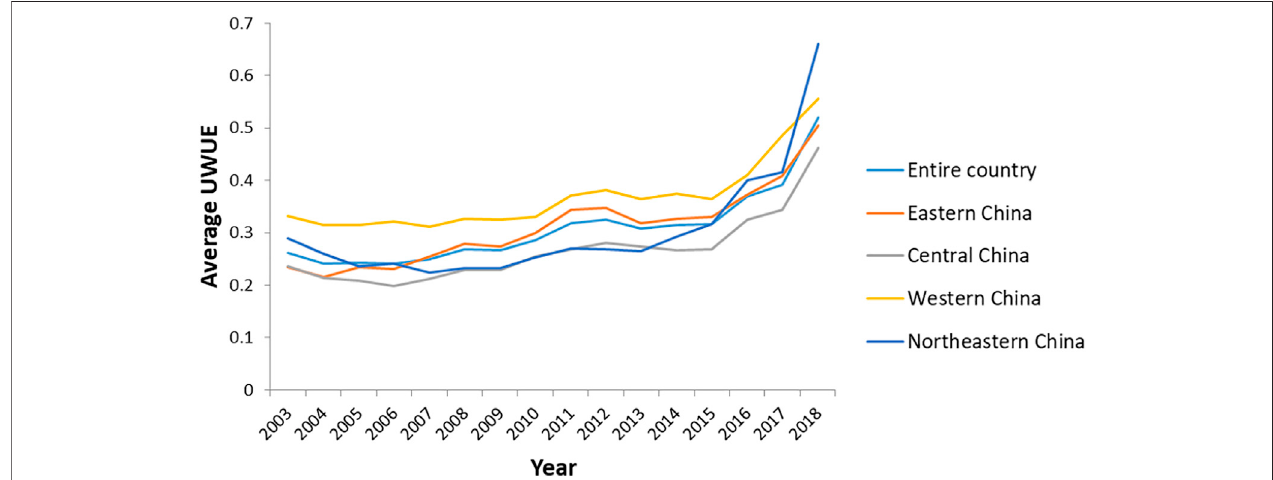
FIGURE 2 | Average UWUEs in China and its four regions.